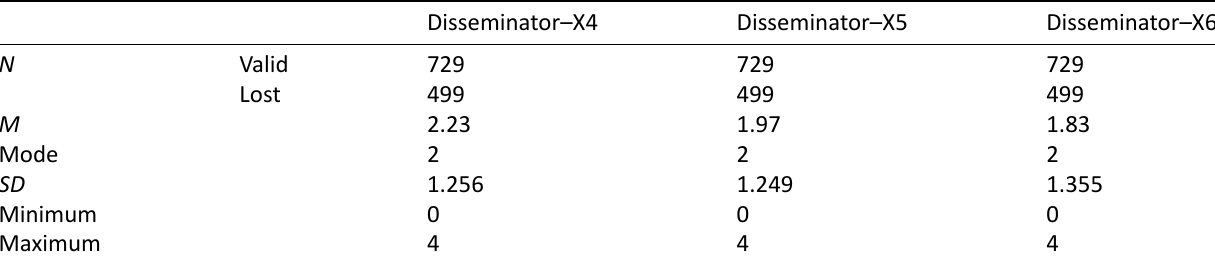
Table 4. Descriptive statistics (disseminator).